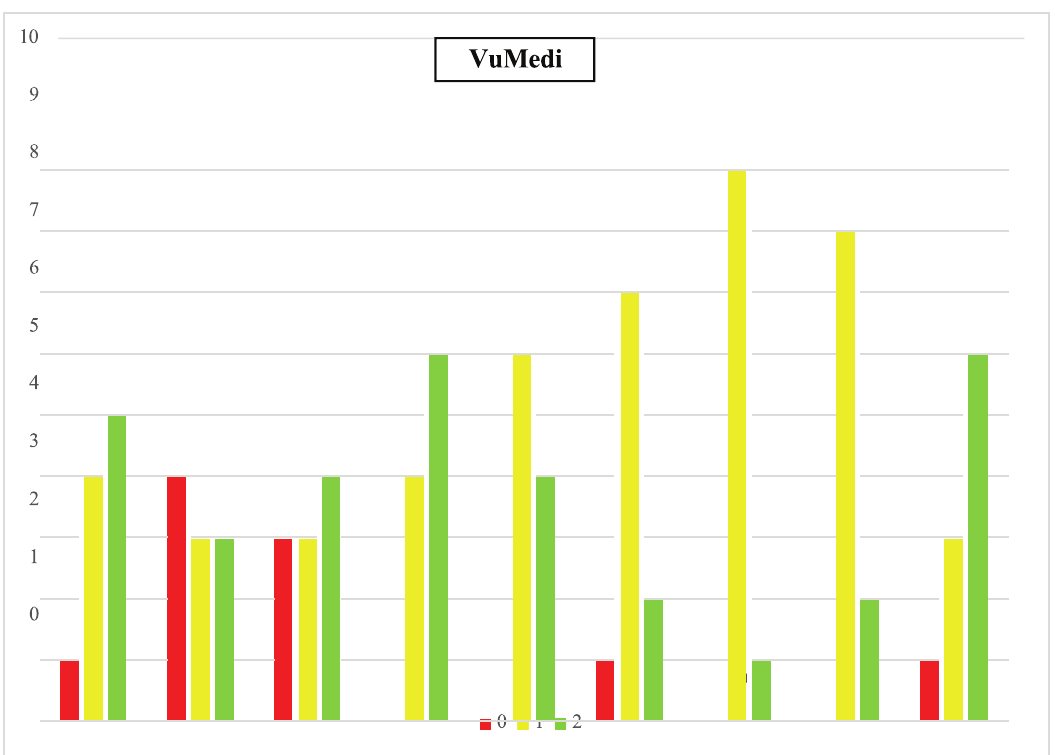
Figure 3. Distribution of scores for each of the nine items of the VuMedi videos. Q1-Q9: Items from the assessment tool: 0 – Item not shown; 1 – Item partially presented; and 2 – Widely featured item.